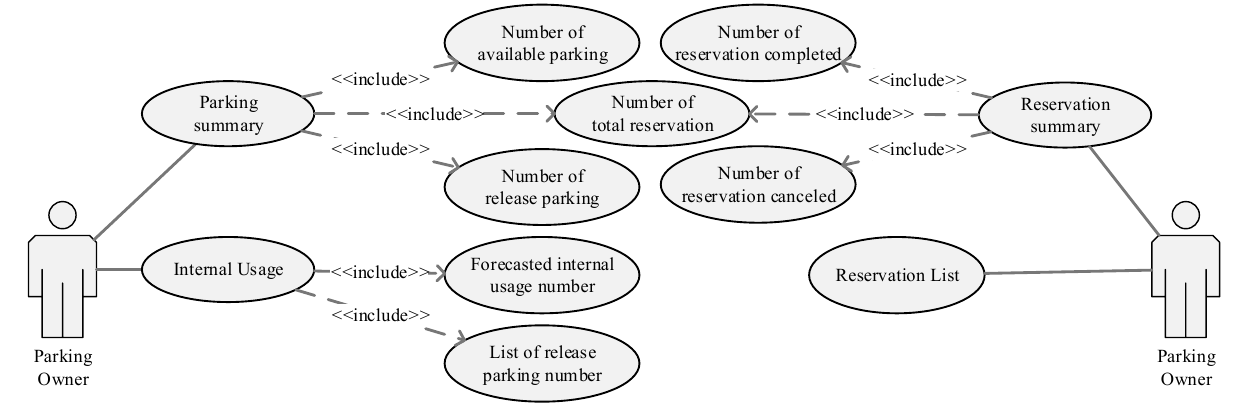
Figure 7. Use case diagram of parking dashboard for parking owner.